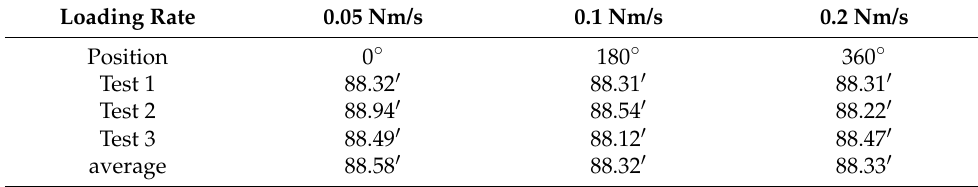
Table 5. Experiment results of δ g .